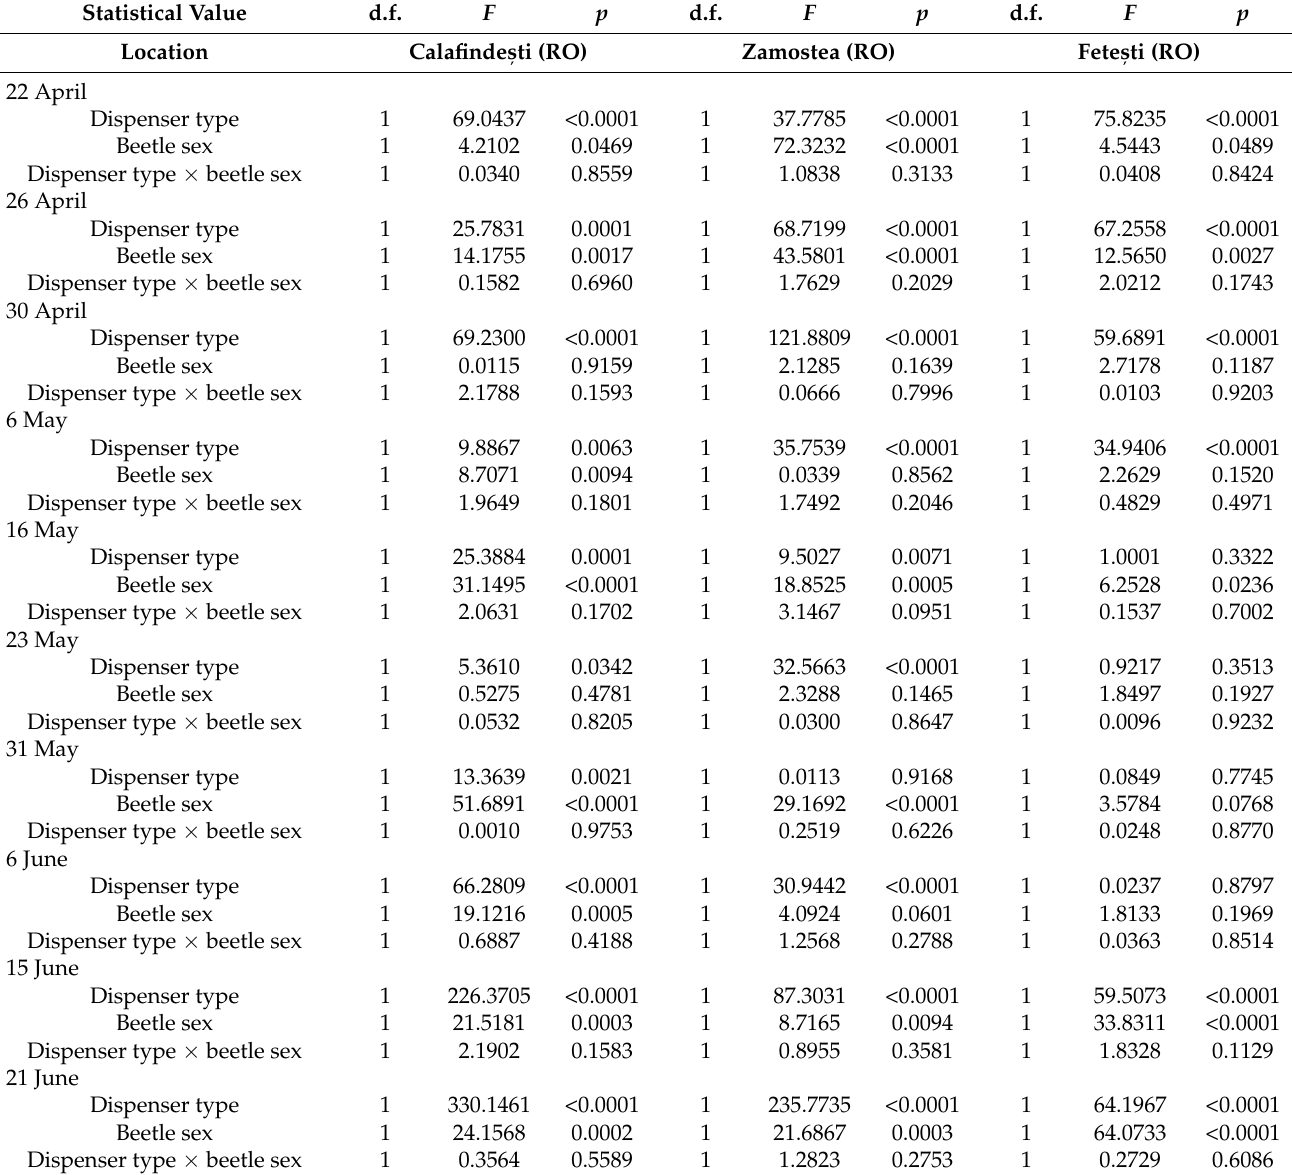
Table 6. Statistical analysis of differences in Ips duplicatus captures for between collection sites depending on dispenser type and beetle sex (ANOVA for Calafindes Kruskal-Wallis for